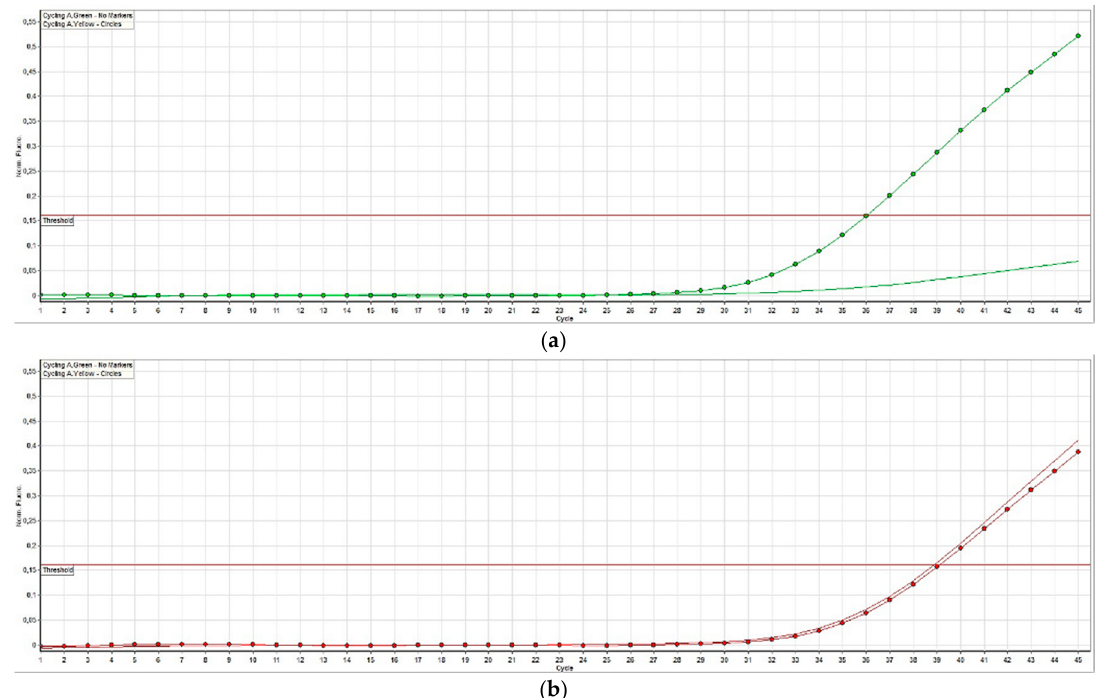
Figure 4. Fluorescent signals detected by the TaqMan ® SNP assay of a canine transitional cell carcinoma. ( a ) In transitional cell carcinoma without BRAF mutation, there is only a signal from the wild-type probe (homozygous thymine, dotted curve) and no signal from the variant probe (curve without dots). ( b ) In transitional cell carcinoma with BRAF mutation (heterozygous thymine and adenine), signal curves of both the wild-type probe (thymine, dotted curve) and the variant (adenine, curve without dots) can be seen.